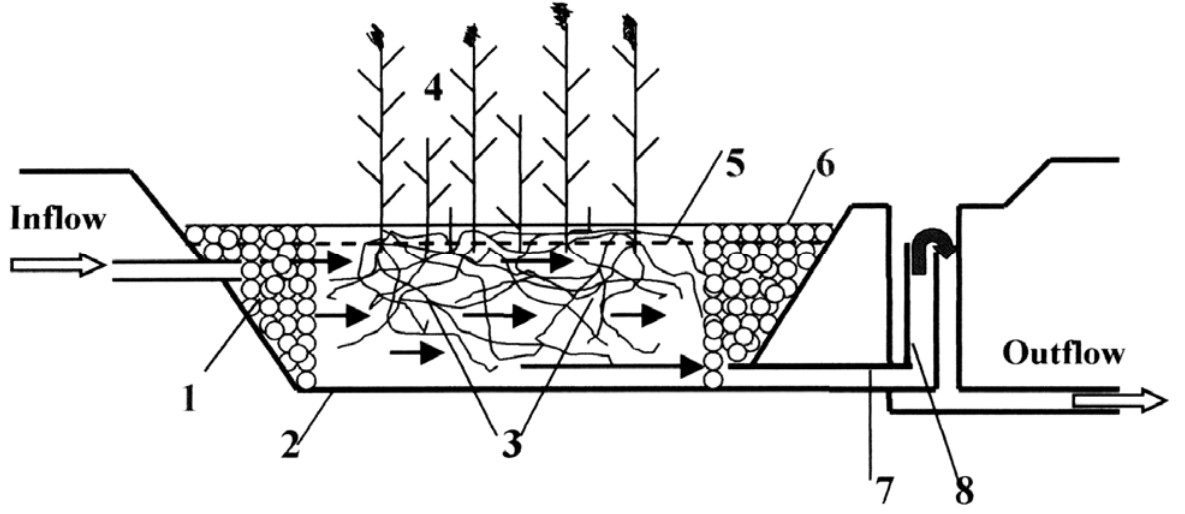
Figure 5. Schematic layout of a constructed wetland with horizontal subsurface flow. 1 inflow distribution zone filled with large stones; 2 impermeable layer; 3 filtration material; 4 vegetation; 5 water level in the bed; 6 outflow collection zone; 7 drainage pipe; Backhuys Publishers.